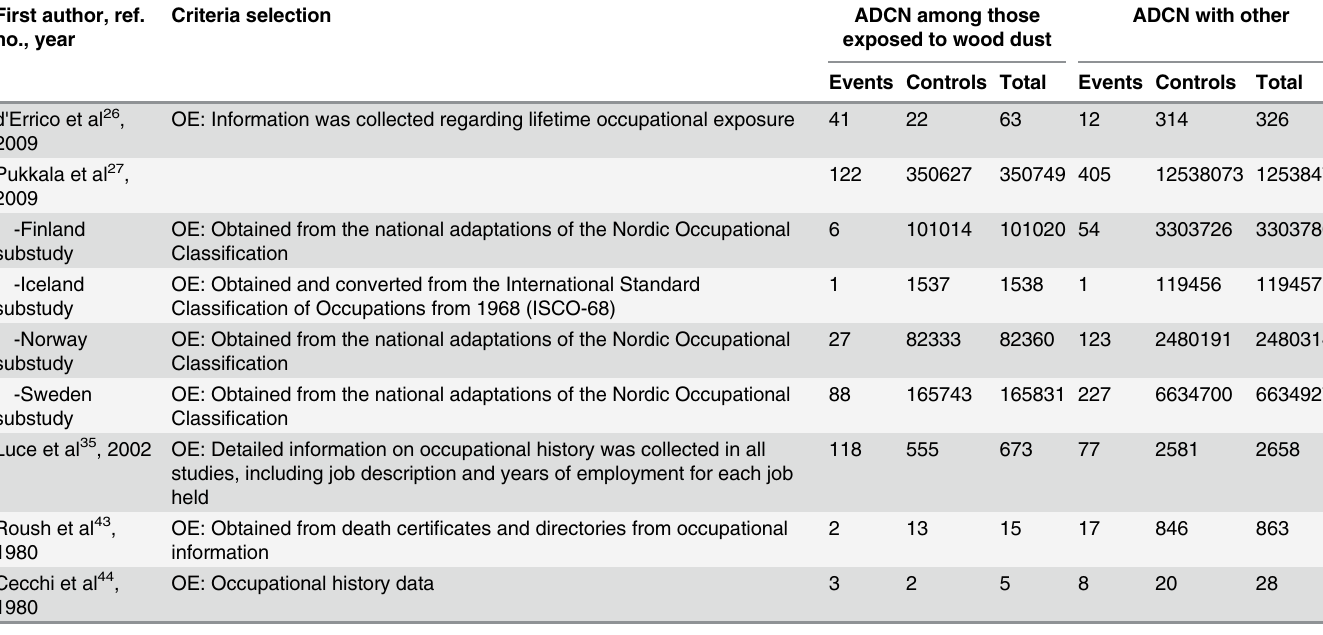
Table 5. Patients with ADCN according to their occupational exposure from studies included in the